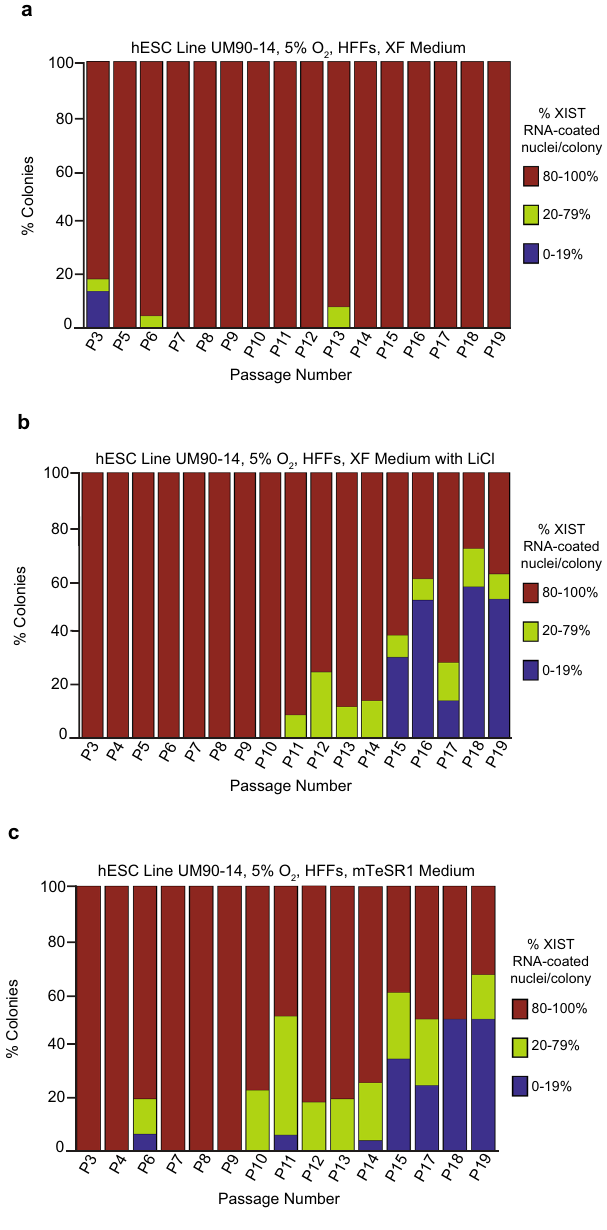
Fig. 6 LiCl in mTeSR1 Medium as a Cause of XIST RNA Loss in Female hESCs. a – c Percentage of nuclei with XIST RNA coating in colonies of hESC line UM90-14 cultured in XF medium ( a ), XF medium supplemented with 0.98 mM LiCl (XF with LiCl) ( b ), and mTeSR1 medium ( c ). hESCs cultured in XF medium did not display a signi fi cant decrease in nuclei with XIST RNA coats across passaging (general linear model, p = 0.2). hESCs cultured in XF medium with LiCl and mTeSR1 medium lost XIST RNA coating in a signi fi cant percentage of nuclei per colony during passaging compared to cells cultured in XF medium (general linear model, p < 0.001). All hESCs in this experiment were cultured in 5% O 2 on HFFs. At least 100 nuclei were counted per colony for hESC RNA FISH quanti fi cation. The total number of colonies quanti fi ed at each passage range between 5 and 78 and are cataloged in source data. Source data are provided as a Source Data fi